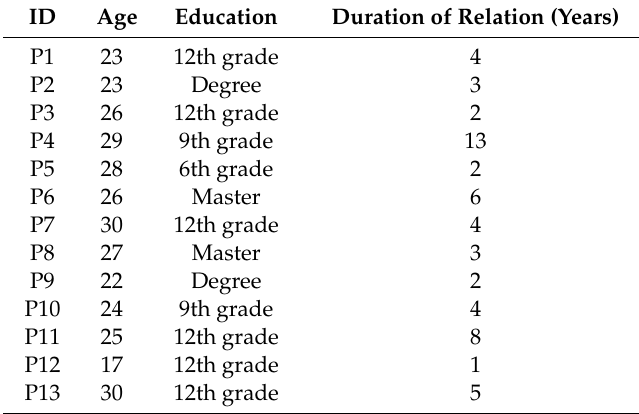
Table 1. Participants’ characteristics ( n =